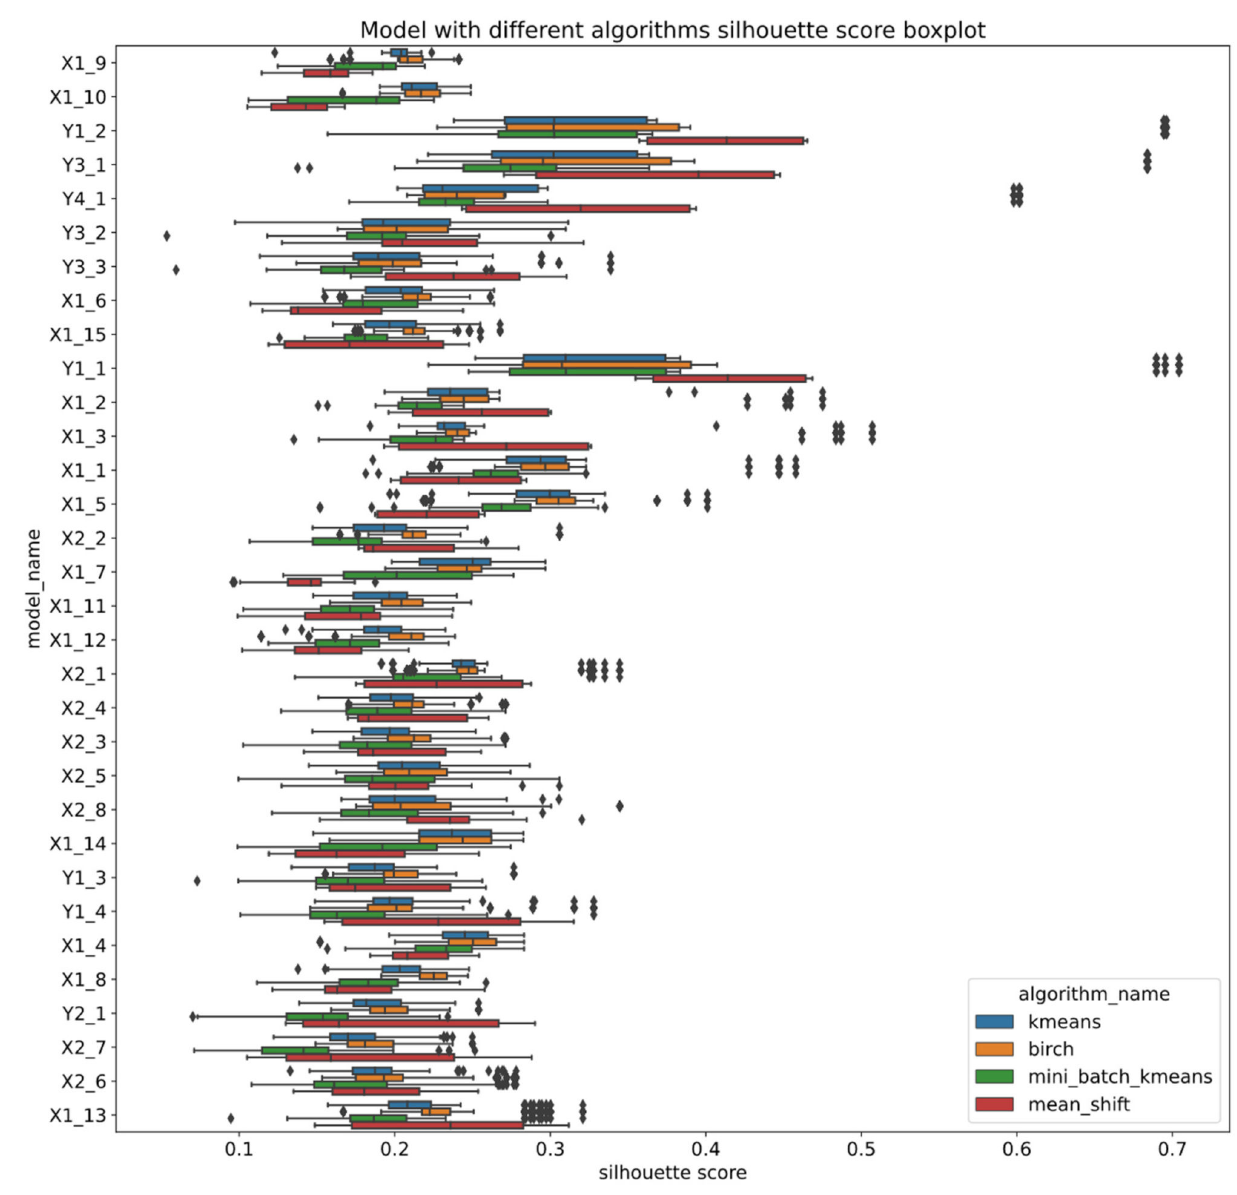
Figure A1. Silhouette score box plots for each model using different